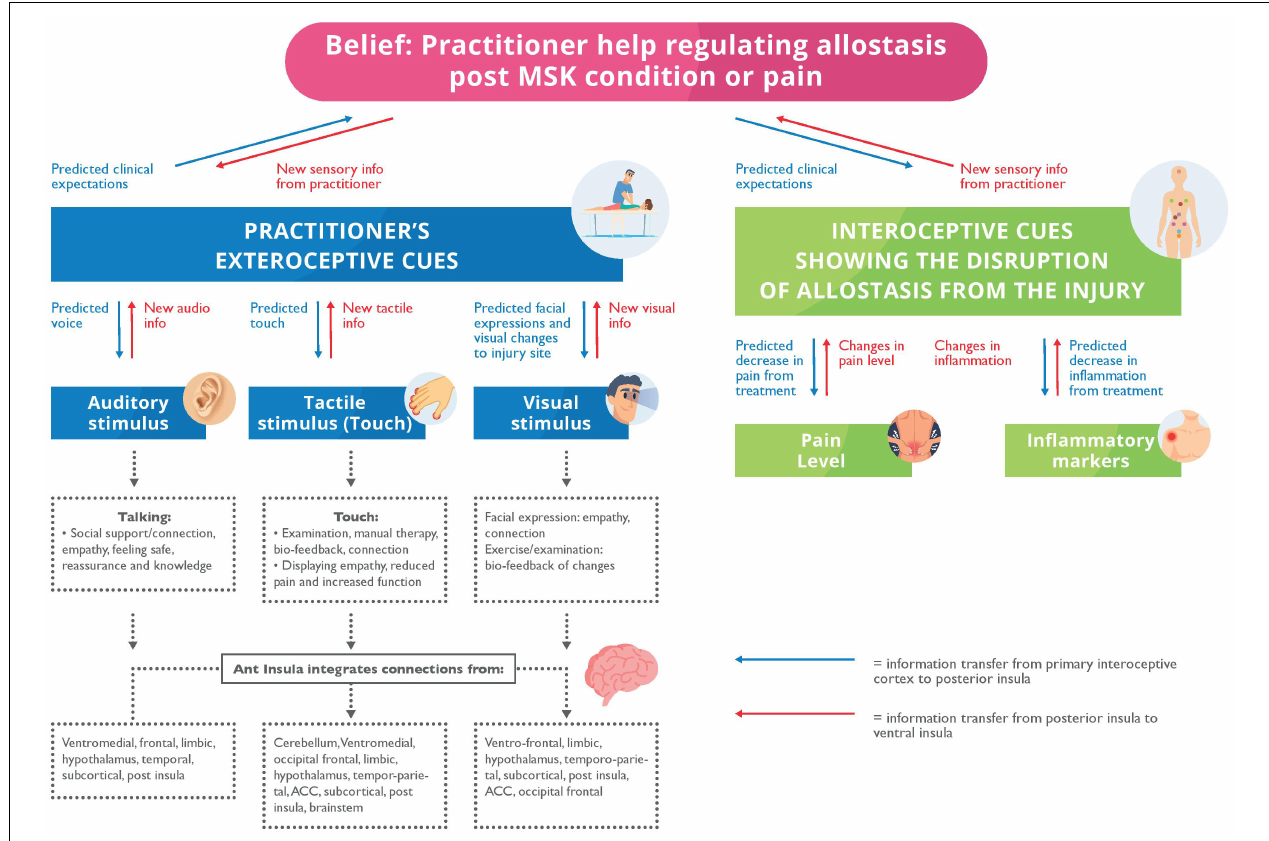
FIGURE 2 | A mode to describe the allostatic regulation by a Health Care Provider (HCP). Blue arrows: The predicted expectations and priors transferring information from the primary interoceptive cortex to posterior insula. Red arrows: New sensory information from the posterior insula to the ventral insular. Exteroceptive: We propose that the patient has predicted expectations for the clinical appointment and predictions about the HCP’s stimuli. We offer putative multisensory mechanisms, i.e., auditory, touch and visual – for allostatic regulation from the HCP. They help display support, empathy, reassurance, and improved clinical function; all are originating from the anterior insula. The anterior insula integrates this multisensory input for allostatic regulation from the cerebellum, ventromedial, limbic, temporoparietal, subcortical, posterior insular, occipital frontal, temporal cortices, anterior cingulate cortex, hypothalamus, and brainstem. Interoceptive: The patient will predict or expect clinical expectations of interoception because of treatment including reduced pain and inflammation which we propose originate from new tactile and proprioception (i.e., haptic) stimulation from the